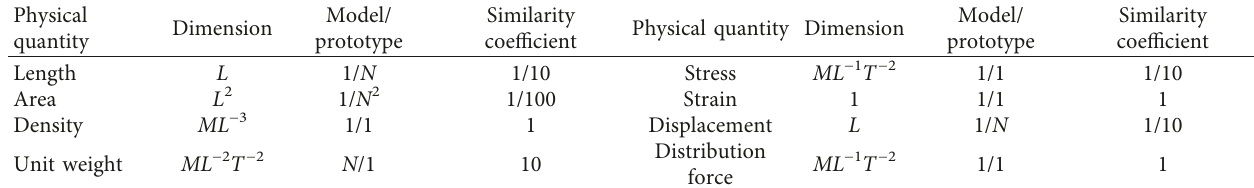
Table 2: Similarity relation of physical quantities.